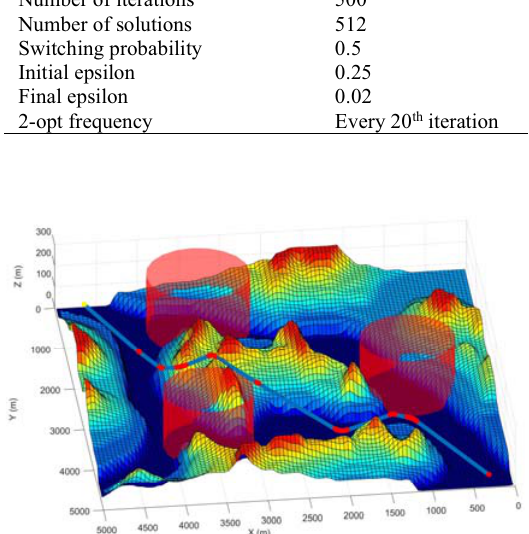
Fig. 5. UAV trajectory computed by the FPA for the canyon map (synthetic map, 25 km 2 , terrain elevation from 0 to 260 m AMSL)